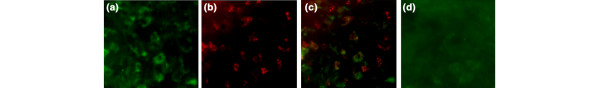
Colocalization of Mac-3-positive cells and NIR2-folate uptake cells in a lipopolysaccharide-induced arthritic ankle 48 hours after NIR2-folate injection. (a) Immunofluorescence staining for activated macrophage revealed in the FITC channel. (b) NIR2-folate uptake cells are revealed in the near-infrared fluorescent channel. (c) Superimposed image shows Mac-3-positive cells colocalized well with NIR2-folate cellular origins. (d) A negative control without primary antibody. Original magnification, 400 ×.